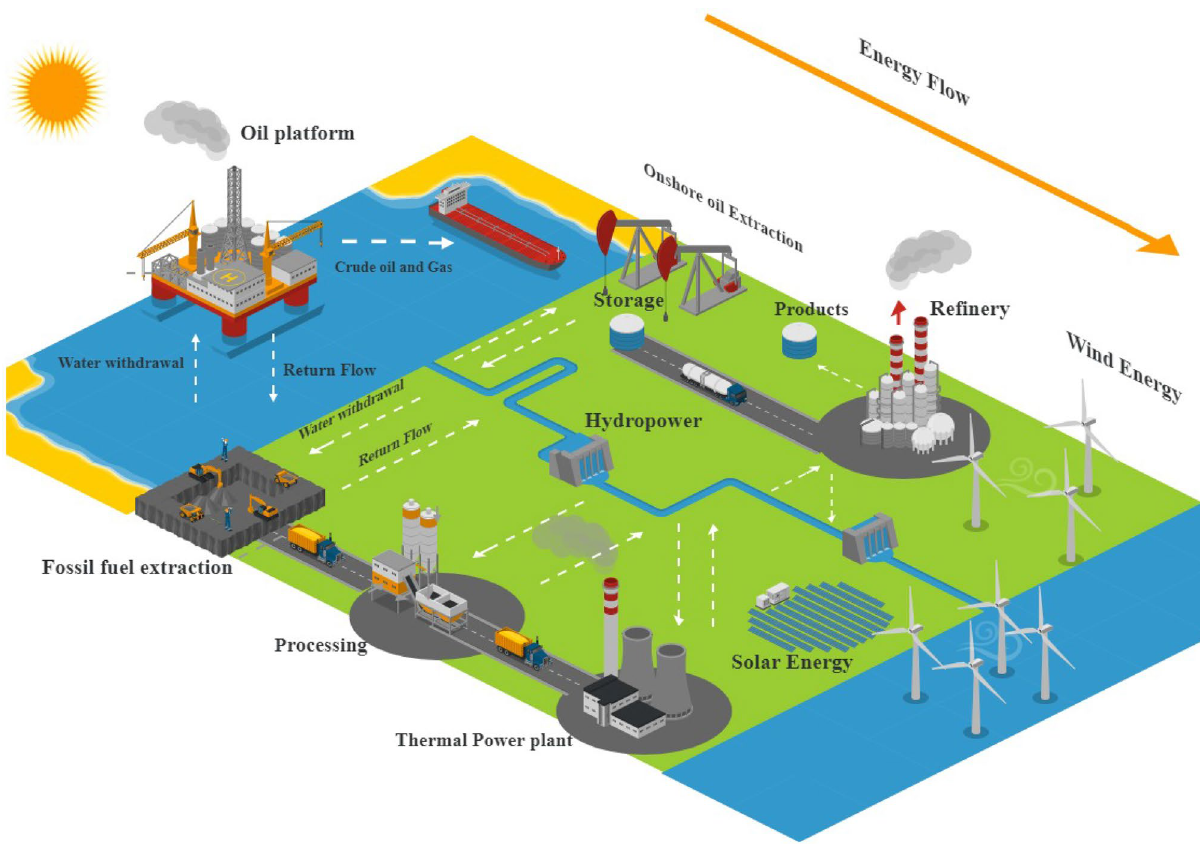
Figure 7. The structure of the Supply-side of the energy subsystem in the context of the WEF nexus